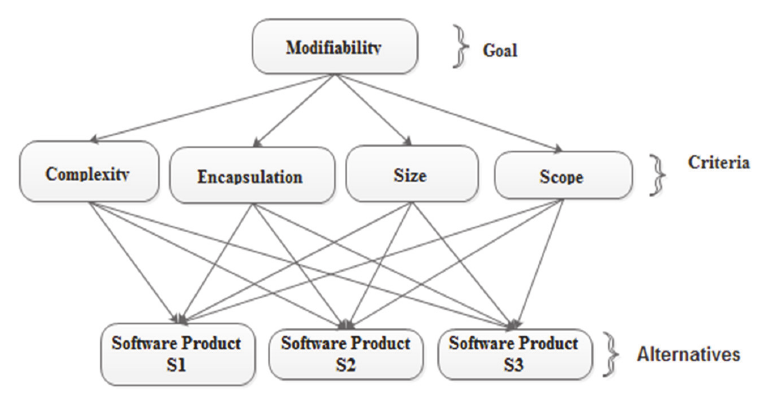
Fig. 5. Hierarchical Structure of